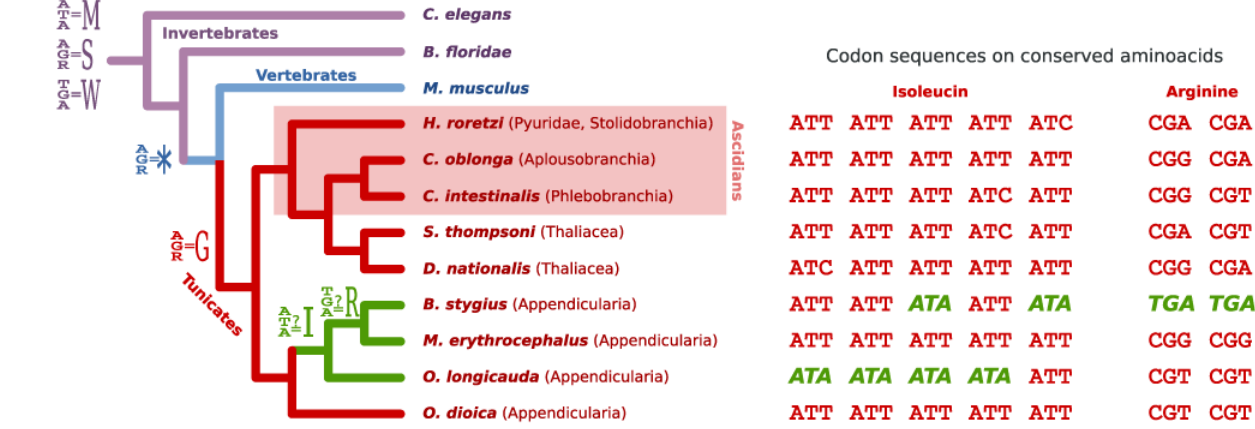
Figure 1. Left: Cladogram illustrating the relations between the species selected in study. Different branch colors indicate different mitochondrial genetic codes. Codon assignments with an equal sign indicate how the nucleotide sequences were translated. Codon assignments with a question mark indicate a possible finding, but were not used for translation. Ascidians, in which the AGR to Gly codon reassignment was initially discovered, are highlighted among the tunicates. Right: codon sequence of Cox1 genes on positions where proposed changes of genetic code would make all species use the same amino